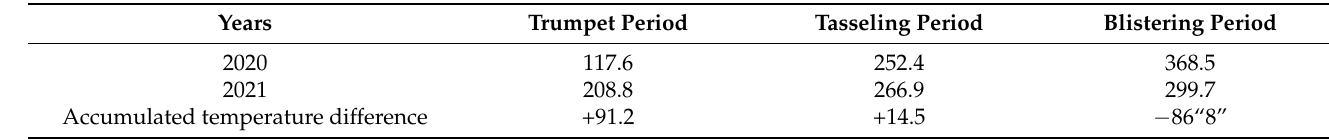
Table 9. Rainfall data in each growth period in two years